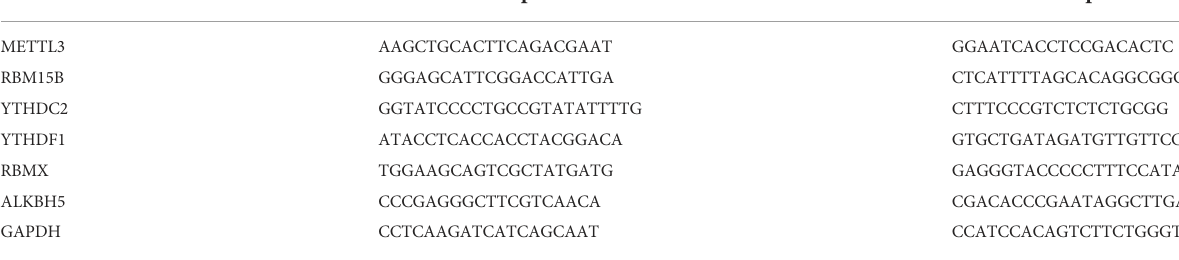
TABLE 1 Primer sequences for real-time